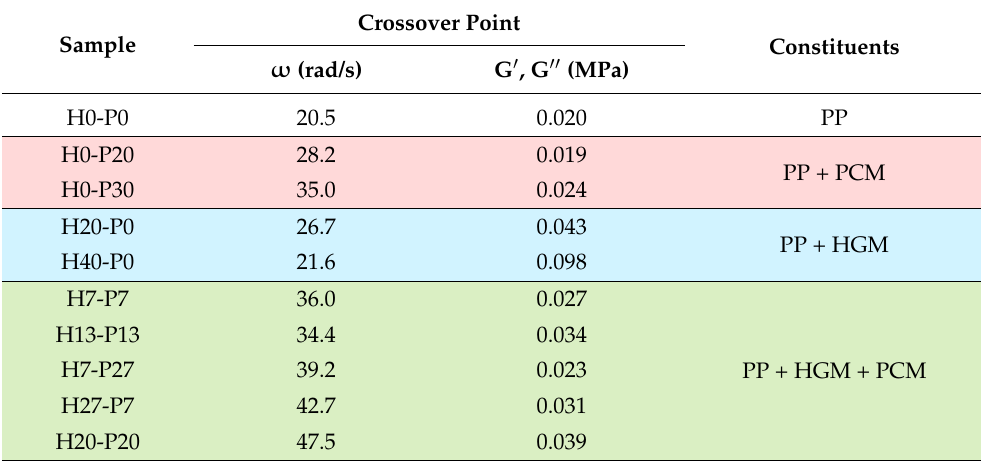
Table 1. Crossover point coordinates of all the analyzed samples.